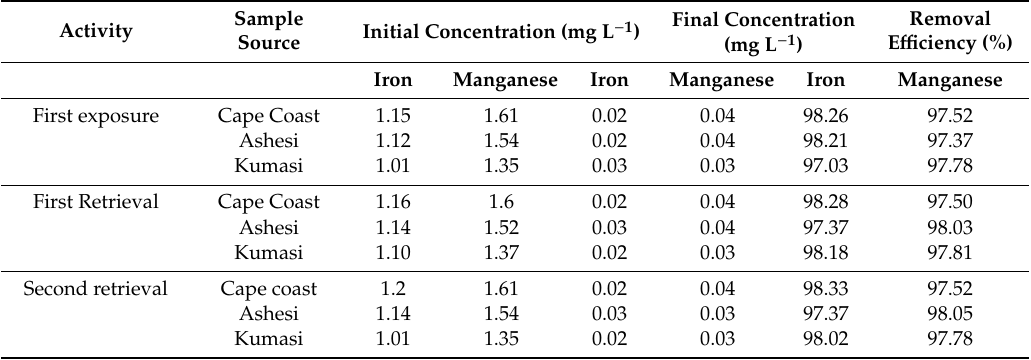
Table 3. Removal efficiency of zeolite Y on iron and manganese in underground water samples. The amount of zeolite Y used were 3 g per 300 mL water sample for first exposure, 2 g per 200 mL water sample for first retrieval, and 1 g per 100 mL water sample for the second retrieval.